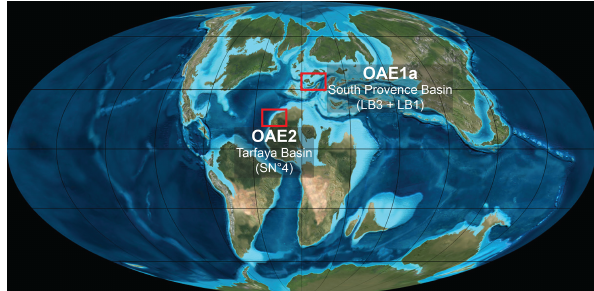
Figure 1. Reconstruction of Late Cretaceous paleogeography at 100Ma (Ron Blakey, Colorado Plateau Geosystems). Red boxes in- dicate the locations of the South Provence and Tarfaya